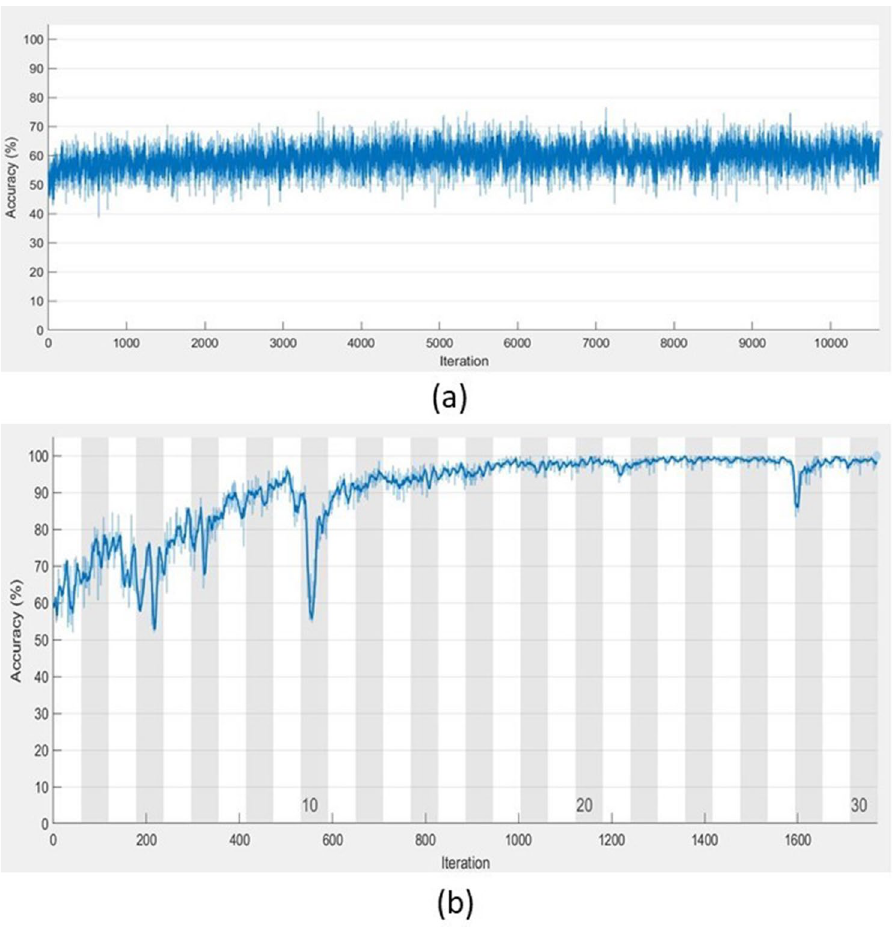
Figure 4. Training processes of ( a ) bi-LSTM and ( b ) TF–TS bi-LSTM, using tenfold cross-validation of the ECG